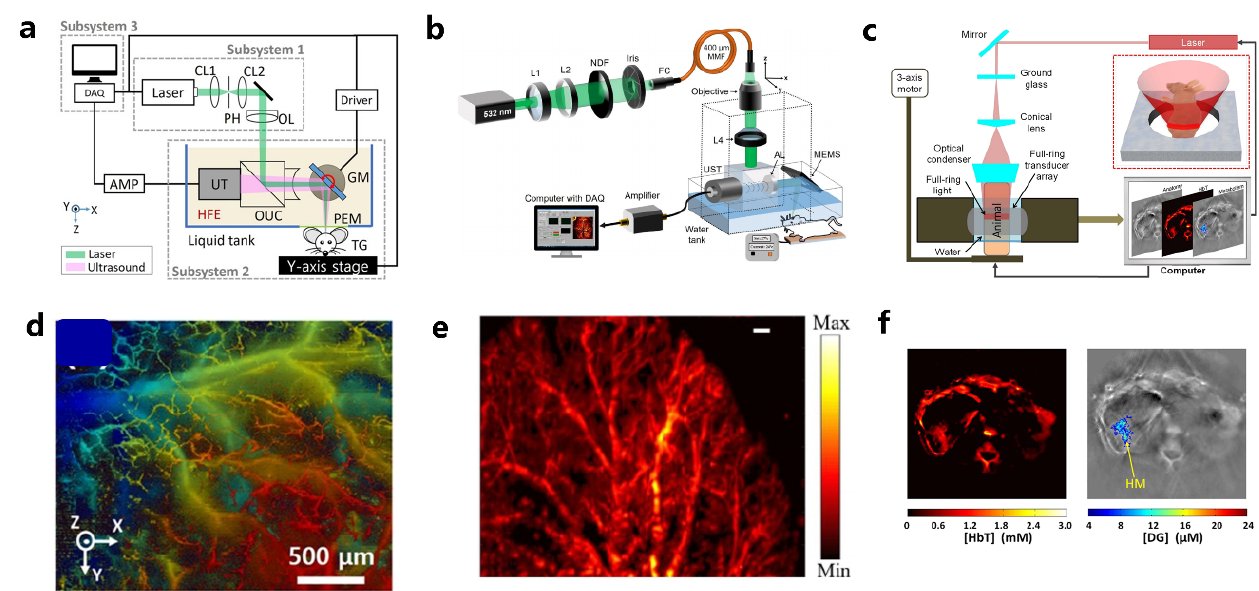
Figure 2. Multiscale PAI systems. ( a ) Schematic of an OR-PAM system using a high-speed galvanometer scanner. Resolution is determined by the focused laser beam spot size. ( b ) Schematic of an AR-PAM system. Resolution is determined by the ultrasound detection system. ( c ) Schematic of a ring-shaped whole-body PACT system. ( d ) Microvasculature of a mouse ear obtained using OR-PAM. ( e ) Vascular imaging using AR-PAM at an ultrasound frequency of 75 MHz. ( f ) PACT images of Hbt concentration (left) and a kidney tumor-specific contrast agent (in color) fused with a structure image (right, in grayscale). Reproduced with permission from [50–52]. Copyright, Nature Publishing Group (2016) [50], John Wiley and Sons (2016) [51], SPIE (2012) [52].